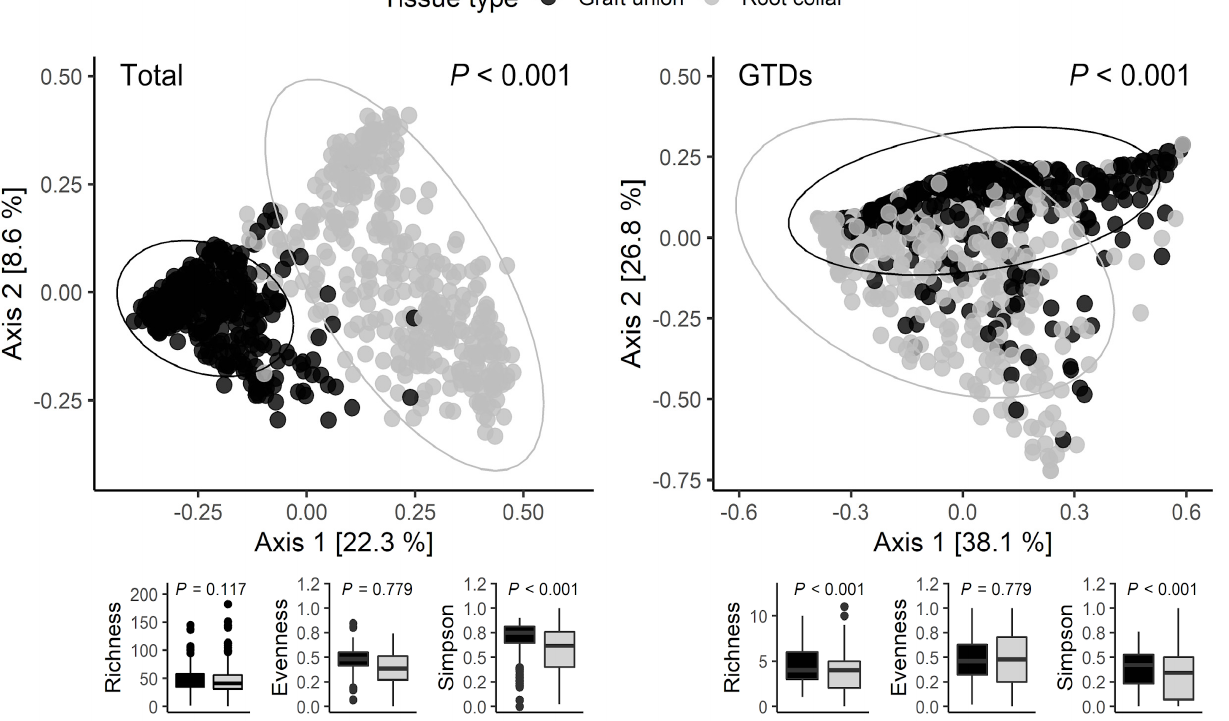
Figure 2. Fungal community structure comparison between all communities ( left ) and GTDs only ( right ) by graft union and root collar tissue types. The figure shows a PCoA ordination calculated with a bray-distance matrix. The R 2 and p-values shown are extracted from a PERMANOVA analysis performed with the adonis2 function in R, in which all design variables are included. Alpha diversity indices (species richness, evenness, and Simpson diversity index) are presented below each figure. Table 3. Contribution of nursery, variety, color, rootstock, and storage to (A) total community var- iation in graft unions, root collars, and both tissues combined (total), compared that of (B) only GTDs. Annotation next to the numbers indicates significance level: *** <0.001, ** <0.01, * <0.05, n.s. = not significant (>0.05).